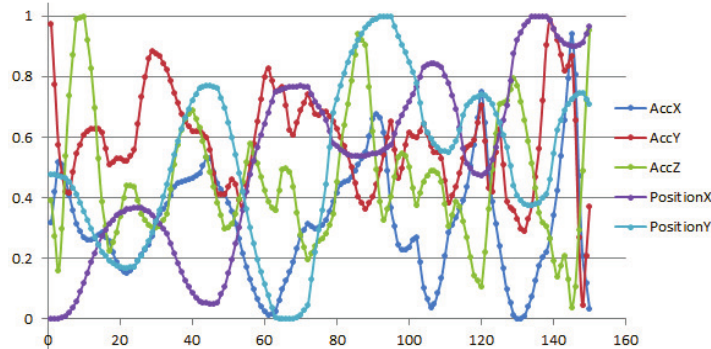
Figure 3. A normalized signature X (cid:48) (sequence of x (cid:48)